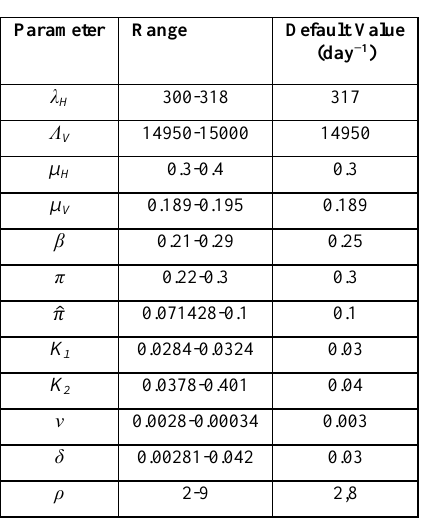
Table 1. List of parameters used in the model equation